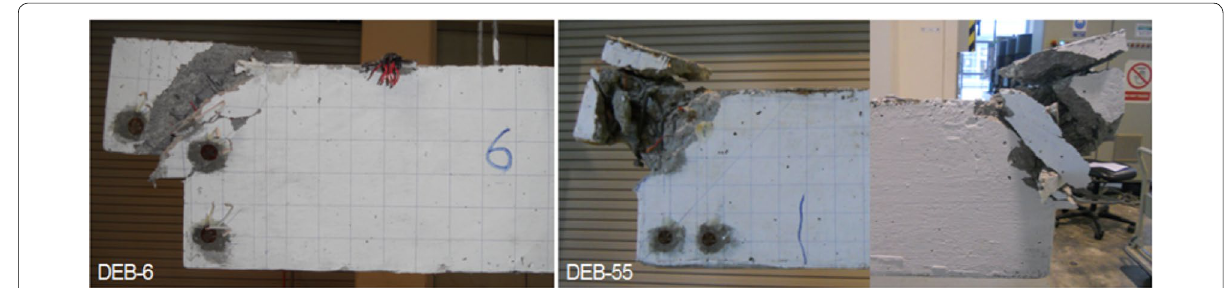
Fig. 10 The beams condition after testing (For DEB-6 and DEB-55).